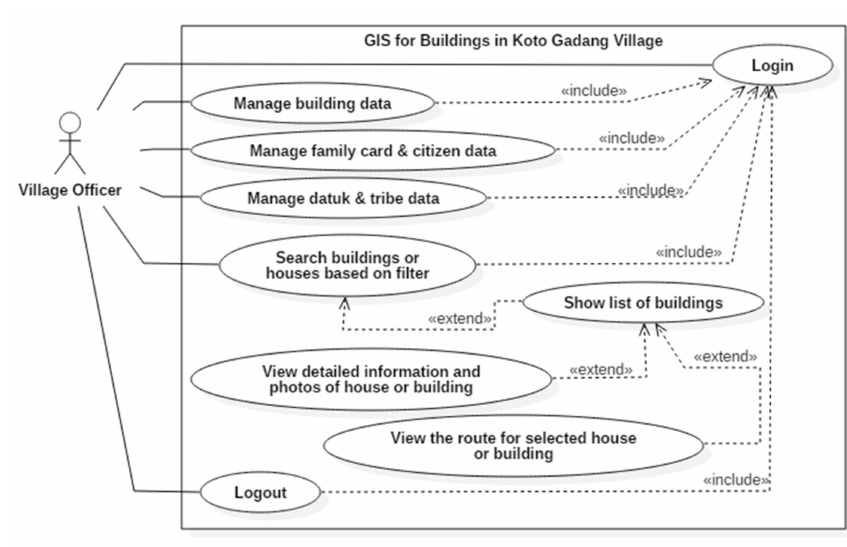
Figure 4. The use case diagram for village o ffi